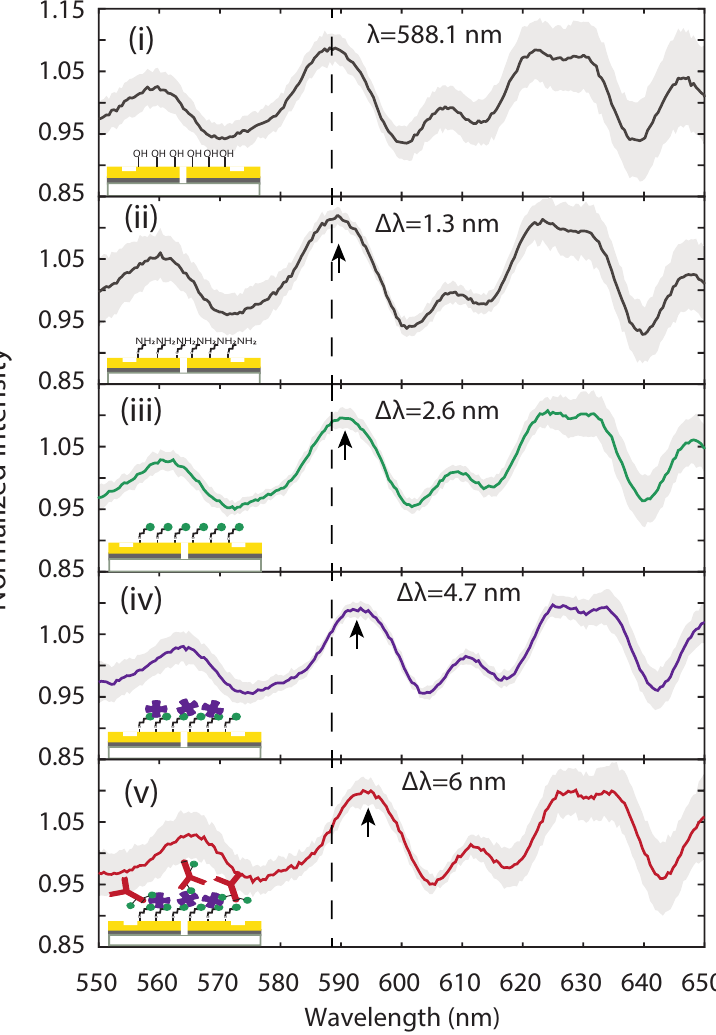
Figure 3. Tracking functionalization steps through plasmonic interference spectra. Measured results of transmitted intensity spectra after ( i ) RCA1, ( ii ) APTES, ( iii ) sulfo-NHS-biotin, ( iv ) strep- tavidin, and ( v ) biotinylated TREM2 antibody treatment. Solid lines represent the mean value of normalized intensity spectra averaged over seven nominally identical GSG interferometers after each functionalization step, as illustrated by the lower left insets. Light gray areas represent standard deviation. The vertical dashed line indicates the position of a representative transmission peak (588.1 nm) that results from constructive SPP interference after RCA1 cleaning. The black arrows mark the wavelength shift ( ∆ λ ) in this reference peak as the result of new constructive interference conditions after each functionalization